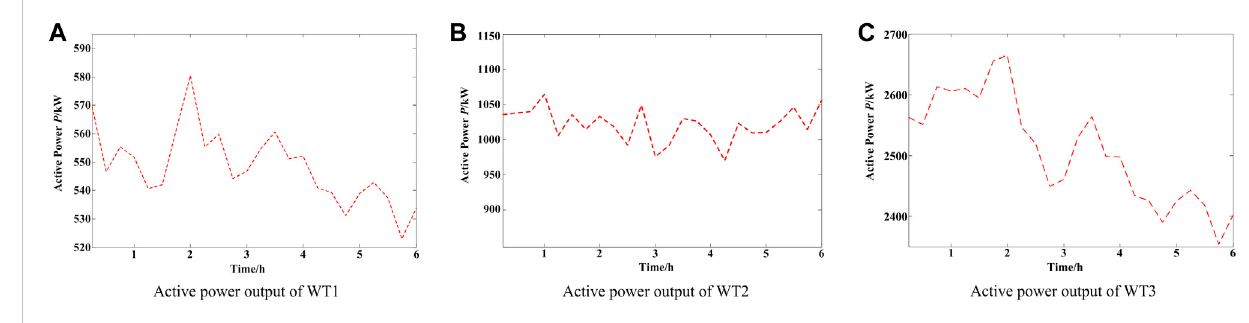
FIGURE 7 Active power output curves of dispersed wind farms.